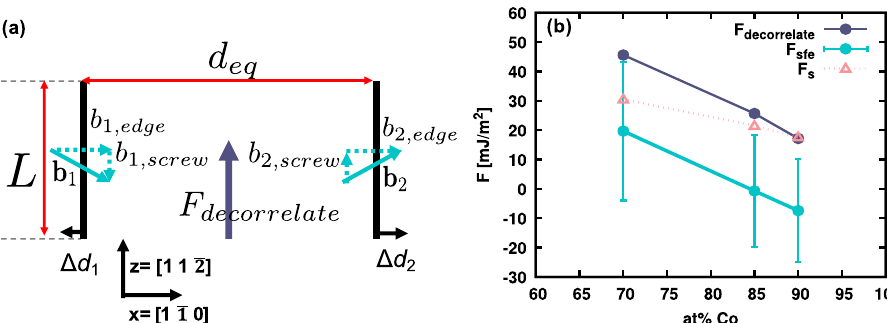
Fig. 6 The decorrelation process of an edge dislocation in the NiCo random alloy. a Schematic of a decorrelation process of two partial dislocations. The burgers vector of the two Shockley partial dislocations ( b 1 , b 2 ) can each be assembled by an edge and a screw component. A decorrelation force ( F decorrelate ), acting parallel to the screw component, will drive the two partial dislocations to break away from equilibrium ( d eq ) and move in opposite directions in the glide plane ( xz ). b The measured decorrelation force compared to the local SFE and force from solutes exerted on the partial dislocation for positive/zero/negative SFE alloys. The error bars represent one standard deviation in local SFE